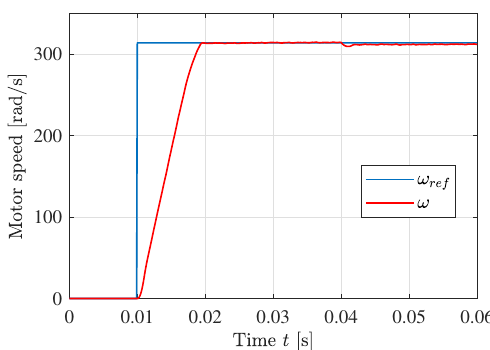
Figure 7. Servomotor closed loop dynamic response using FOC. Rated speed step at t = 0.01 s and rated load step at t = 0.04